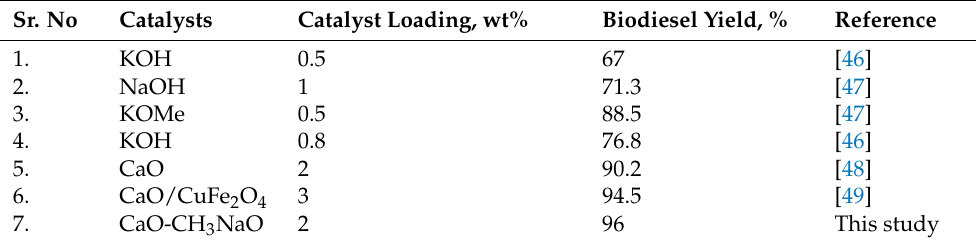
Table 2. Comparative study of biodiesel from waste chicken fat using different catalysts. Sr. No Catalysts Catalyst Loading, wt% Biodiesel Yield,